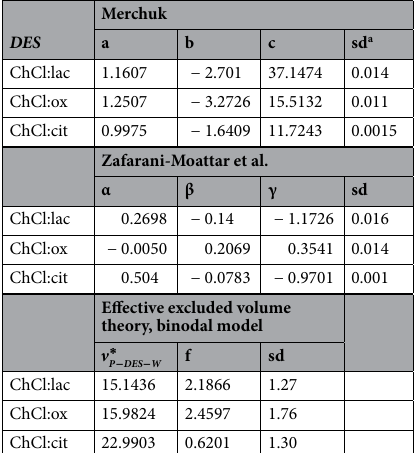
Table 3. Values of parameters of, ( a, b, c ), ( α, β, γ), and ( v ∗ P acids (HBD) + H 2 O} systems at 298.15 K. a sd = mass fraction of PPG400 and number of binodal data, respectively.